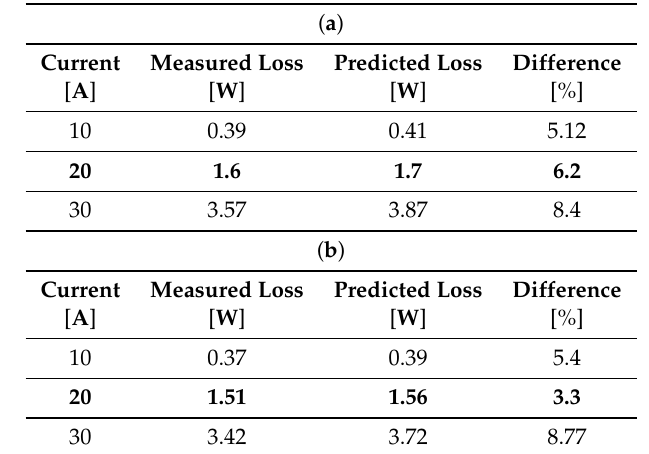
Figure 8. Comparing predicted fault with experimental sample. ( a ) Model sample with 2.2 mm fault width. ( b ) Measured sample with 2.06 mm fault width. ( c ) Model sample with 3.0 mm fault width. ( d ) Measured sample with 2.82 mm fault width. Table 4. Total restive loss comparison for the studied samples. ( a ) Sample 1 with fault width of 2.2 mm (numbers in bold represent the test measurement used to obtain the fault parameters). ( b ) Sample 2 with fault width of 3.0